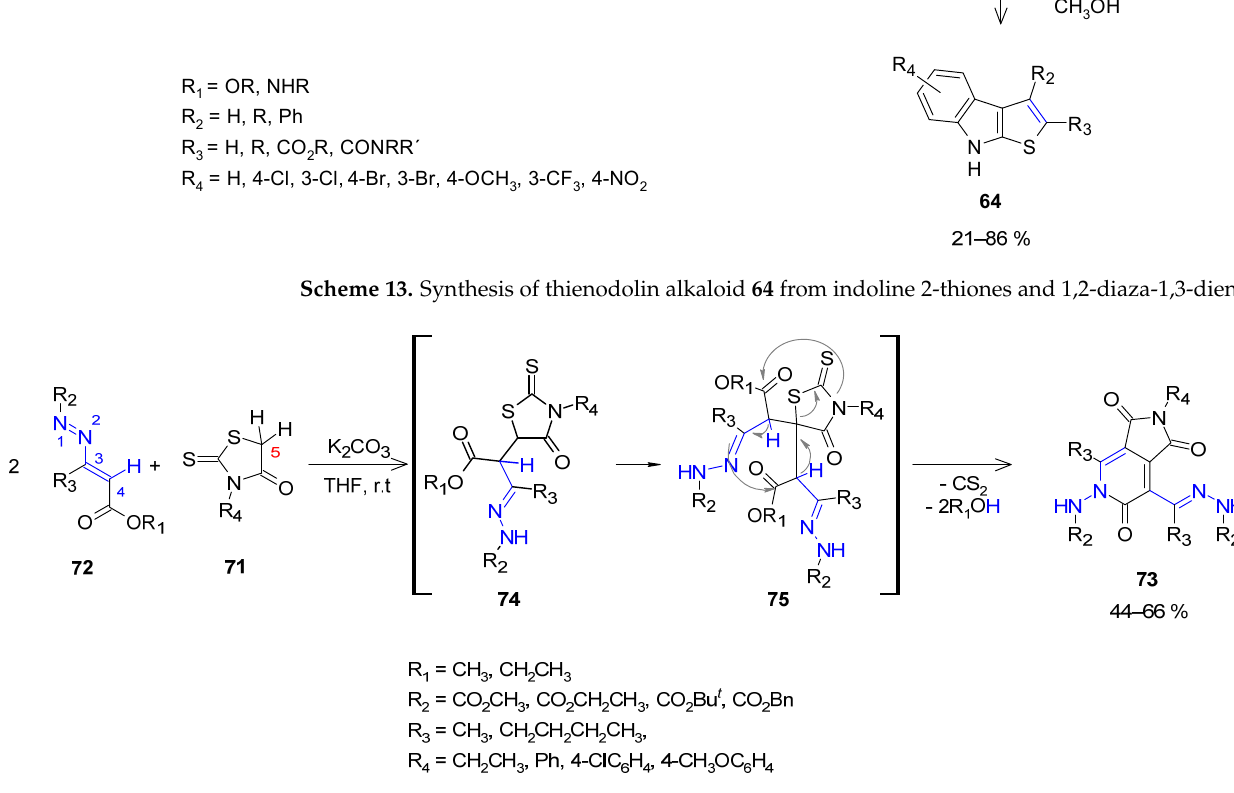
Scheme 13 . Synthesis of thienodolin alkaloid 64 from indoline 2 ‐ thiones and 1,2 ‐ diaza ‐ 1,3 ‐